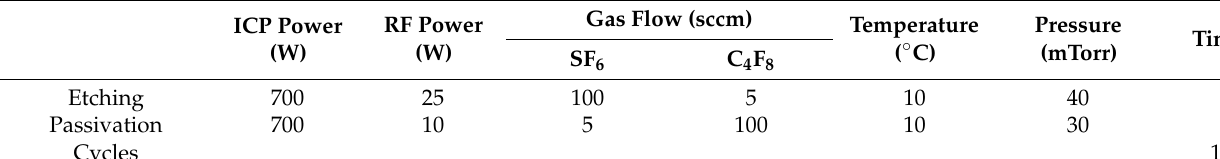
Table 1. Bosch process etching parameters.